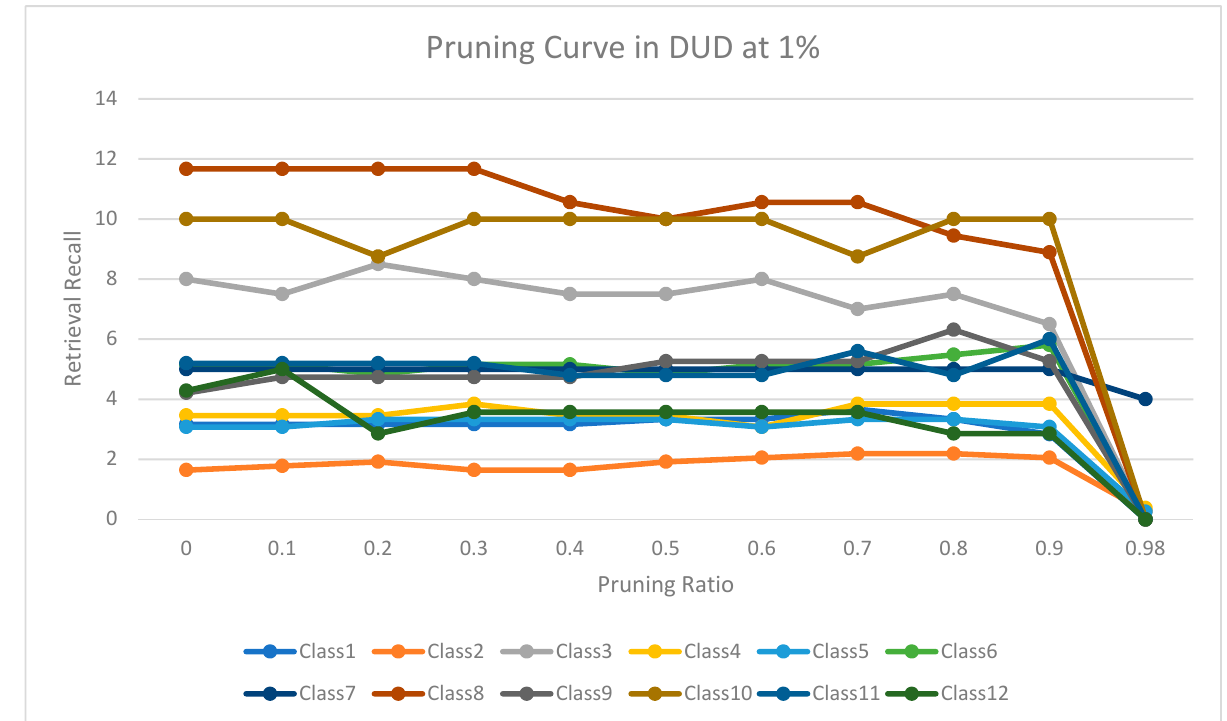
Molecules 2021 , 26 , x FOR PEER REVIEW